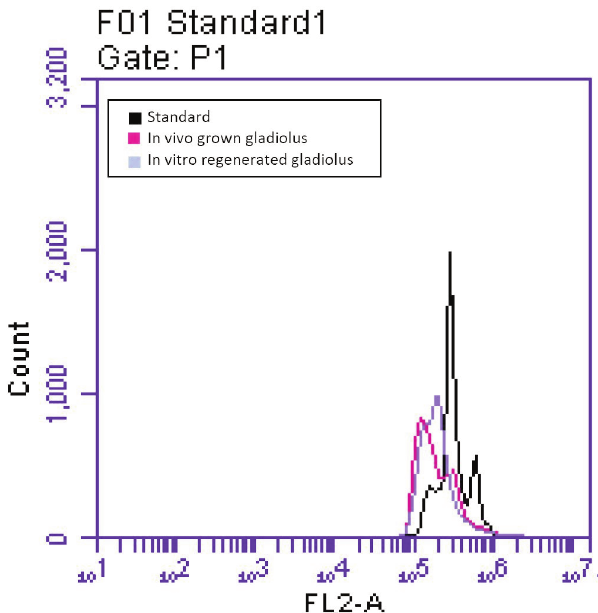
Fig. 3 - Histogram of relative 2C DNA content of corm grown (field) and somatic embryo regenerated gladiolus with standard Pongamia pinnata